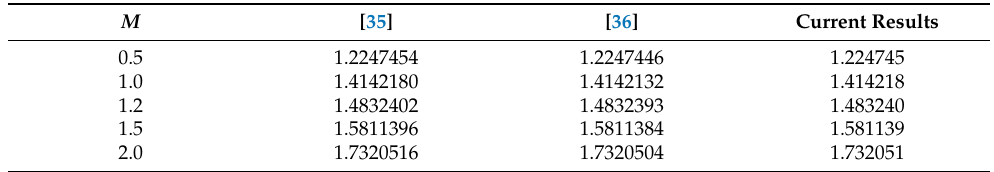
Table 3. The present skin friction outcomes validation against M when other involved parameters are not considered.